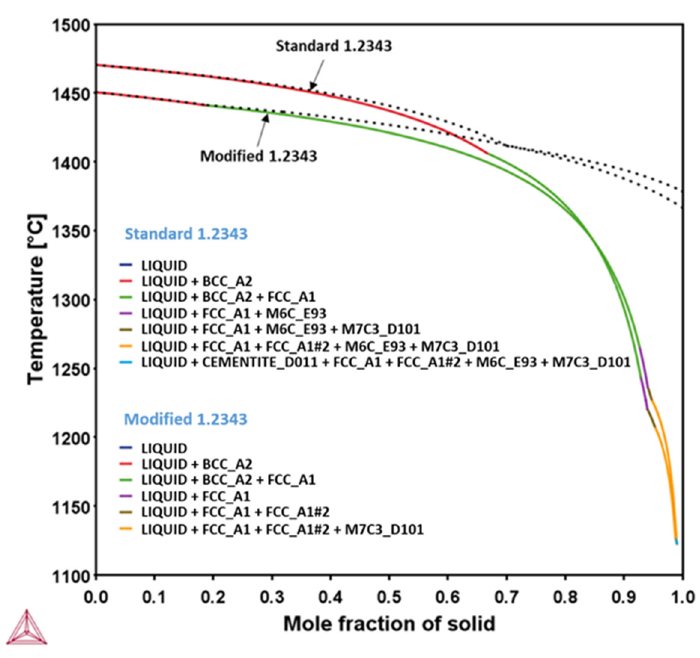
Figure 9. The superimposed Scheil simulation (TCFE10) of both the modified and standard 1.2343. Standard: Formation of δ -ferrite only (1468–1405 ◦ C), γ + δ -ferrite (1405–1265 ◦ C), γ only (1256–1245 ◦ C), M 6 C, M 7 C 3 , MC-cementite Modified: Formation of δ -ferrite only (1454–1439 ◦ C), γ + δ -ferrite (1439–1271 ◦ C), γ (1271–1228 ◦ C), M 6 C, M 7 C